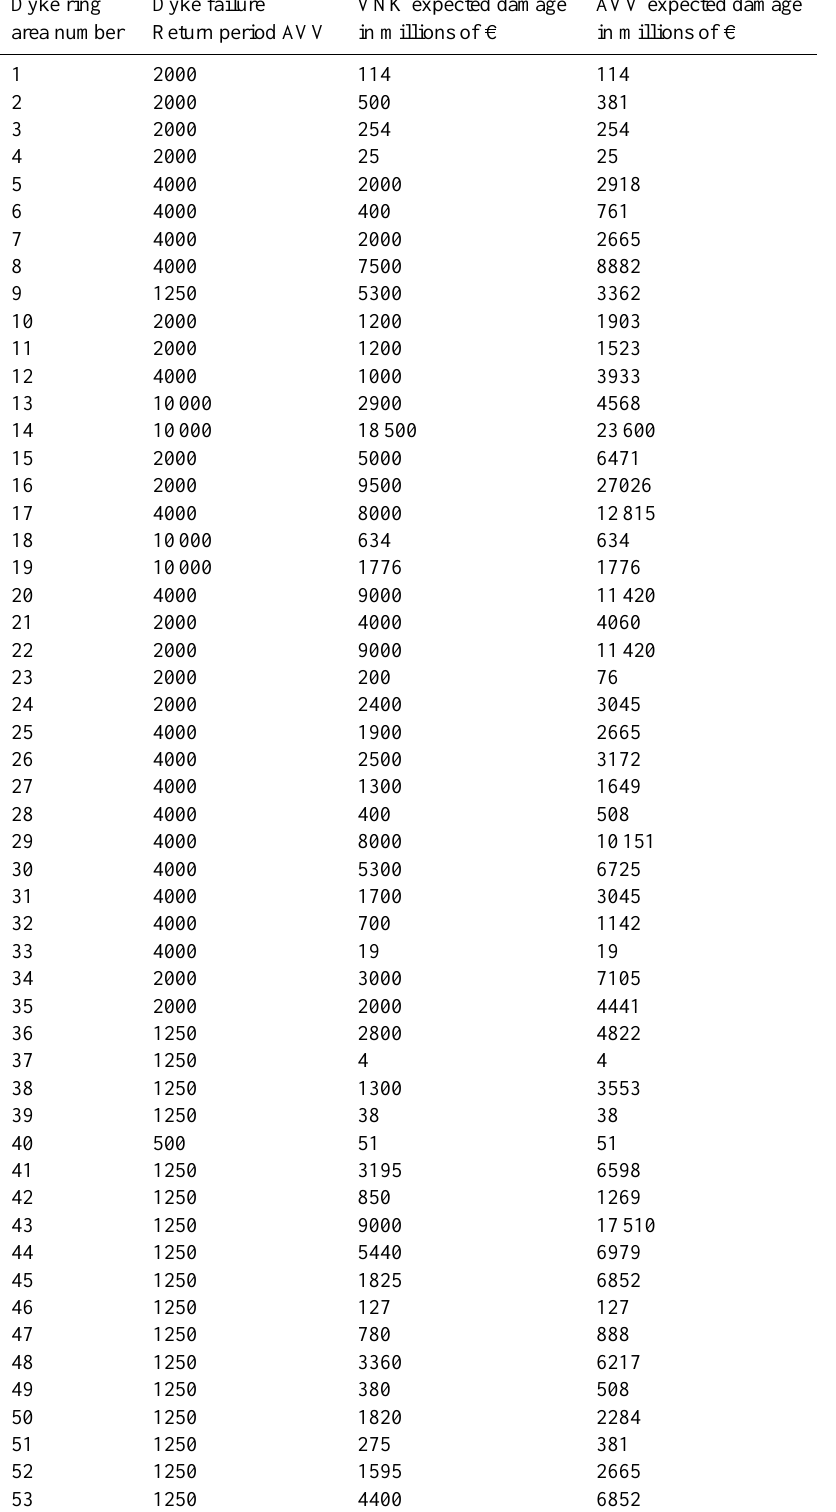
Table A1. The flood risk estimates from the VNK and AVV projects that were used as input data for the Bayesian model. Dyke ring Dyke failure VNK expected damage AVV expected damage area number Return period AVV in millions of C in millions of